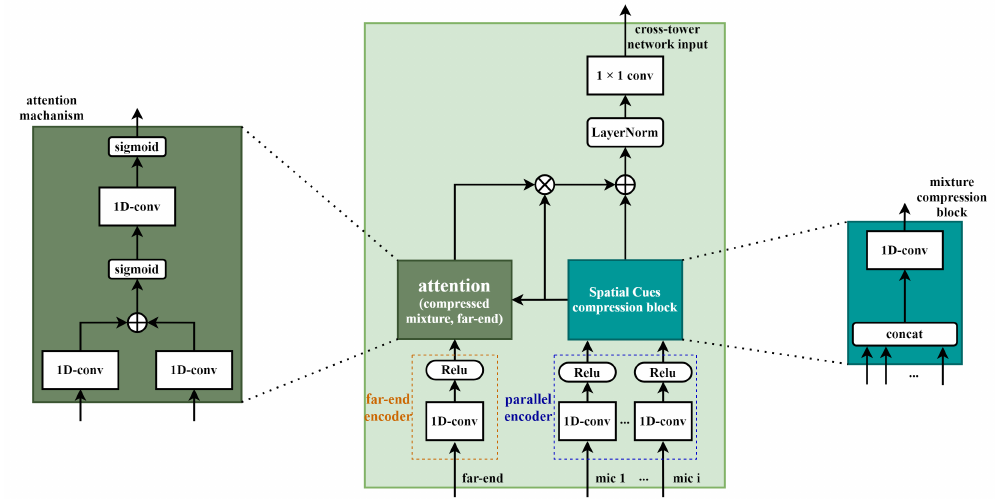
Figure 3. Mic encoders and auxiliary encoder with an attention